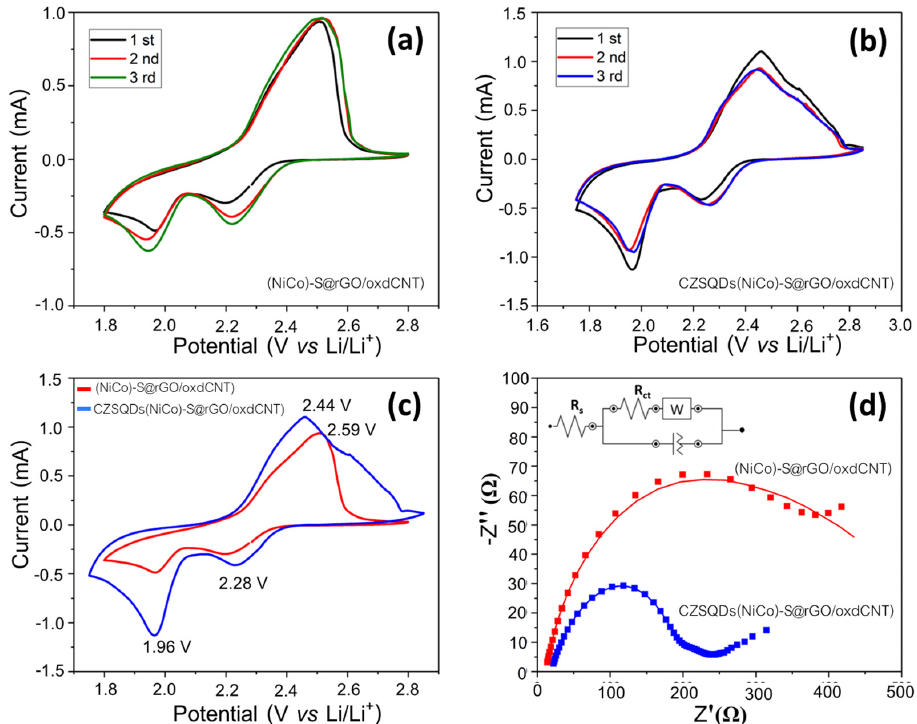
Figure 15. CV curves for the cells with ( a ) and without ( b ) CuZnS quantum dot (CZSQDs) decorated-(NiCo)–S@rGO/oxdCNT for the first three cycles at 0.1 mVs − 1 . ( c ) comparison of CV curves and electrochemical impedance spectra (EIS) ( d ).